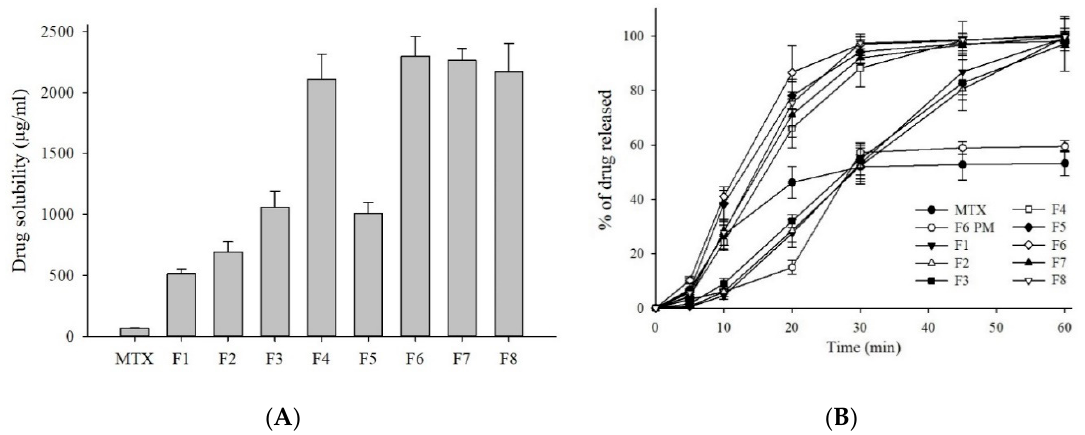
Figure 2. Drug solubility ( A ) and dissolution profiles ( B ) of MTX powder and MTX-loaded formulations. Each value represents the mean ± SD ( n = 3).